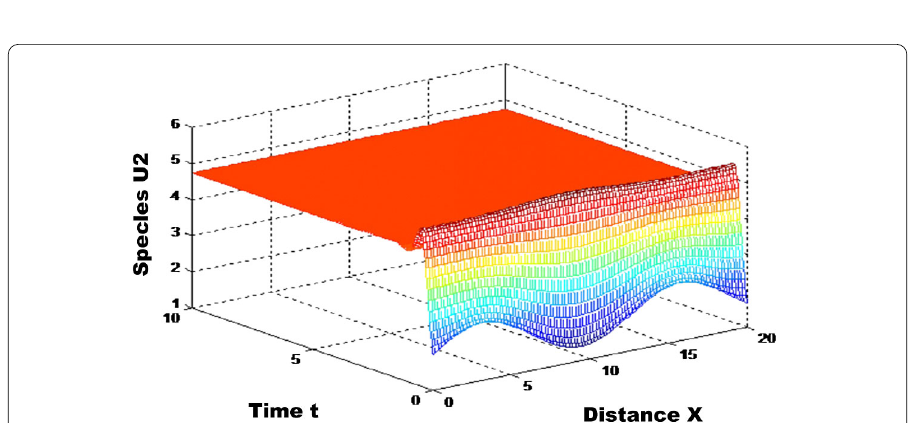
Figure 1 Dynamic behavior of solution u 1